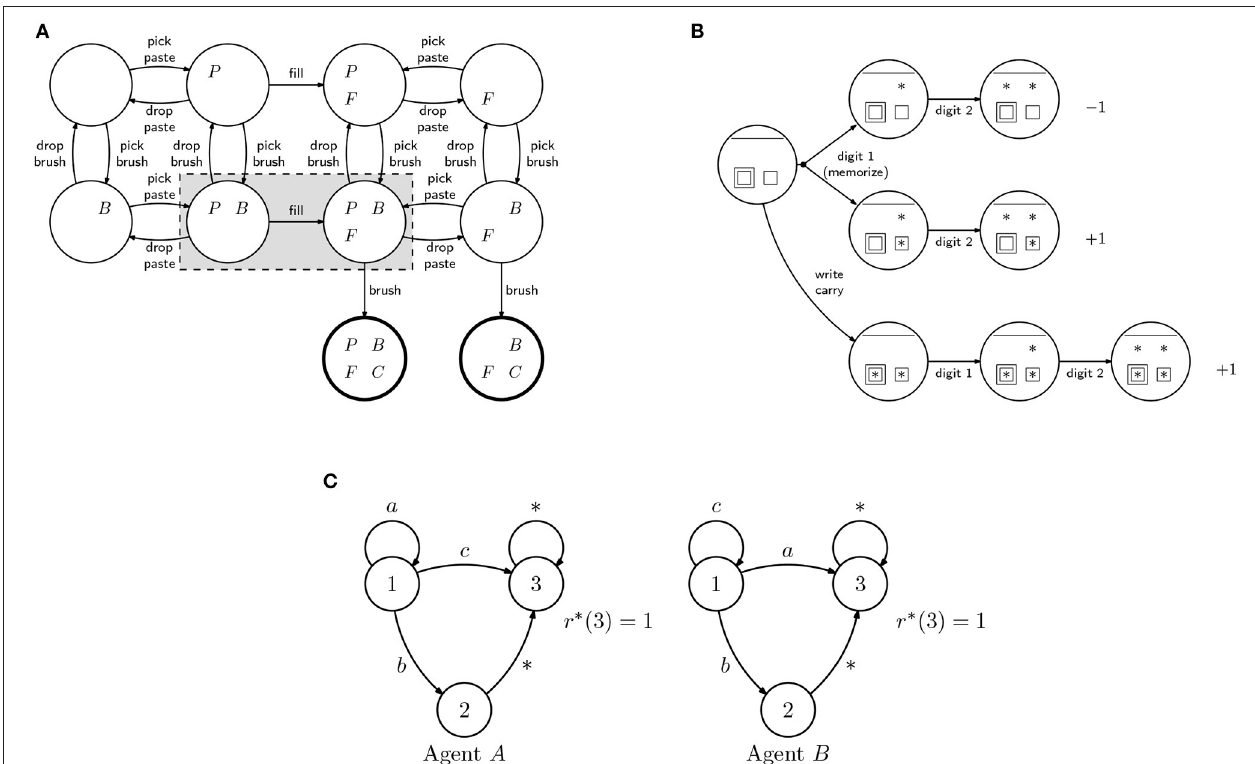
FIGURE 5 | MDPs used in the examples. (A) Teeth brushing example: Each state is described by 4 binary features: P (holding paste), B (holding brush), F (brush with paste), and C (teeth clean). We consider the case where one user that cannot hold two objects at the same time and so some of the states are inaccessible (states in the shaded region). (B) Addition with carry: Simple model of 2-digit addition with a single carry. The asterisks represent digits. Some learners are able to memorize the carry digit (the single square) and do not have to explicit write it (the double square). If memorizing may fail (top path), the teacher might suggest to write the carry digit explicitly (lower path). Without writing the carry digit, a learner with difficulties may forget it (the top branch has higher probability), obtaining the wrong result. (C) Alternative paths MDP: 3-state MDP, where the task to be learned is to reach state 3, for which there are two paths: a direct one and a longer one, going through state 2. The two agents differ in the transition probabilities associated with actions a and c